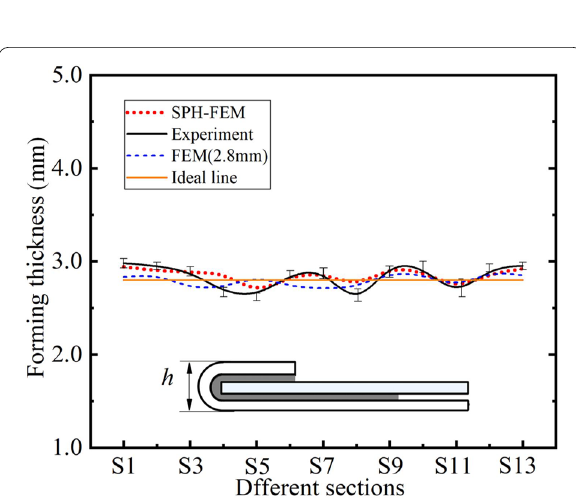
Figure 10 Transient pressure and velocity of SPH particle in the middle section